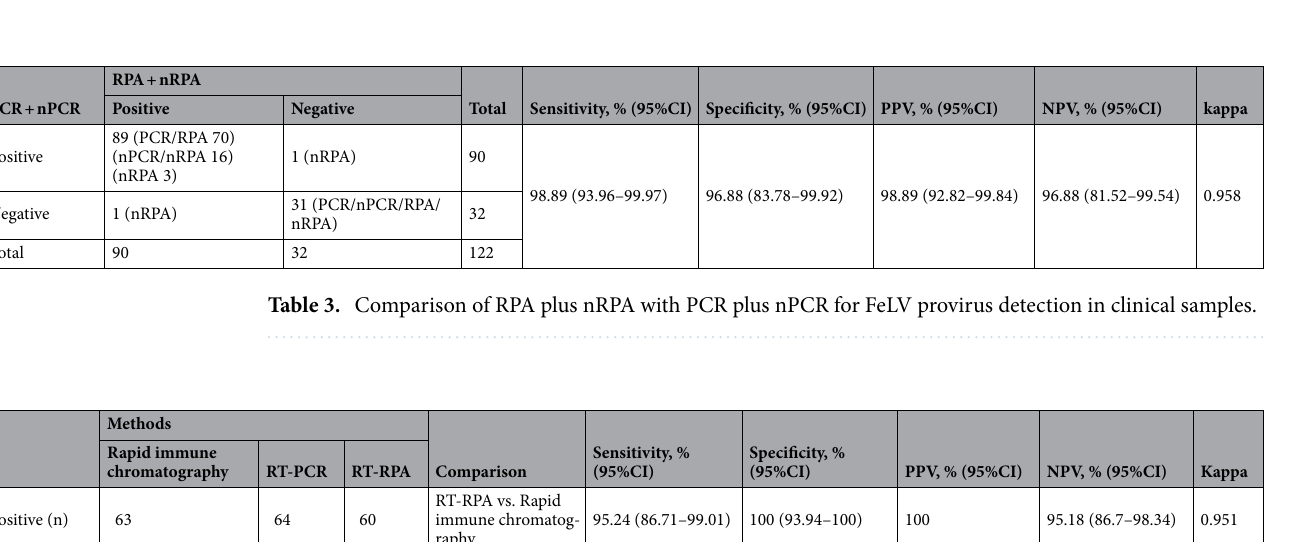
Table 2. Comparison of RPA and PCR for FeLV provirus detection in clinical samples.